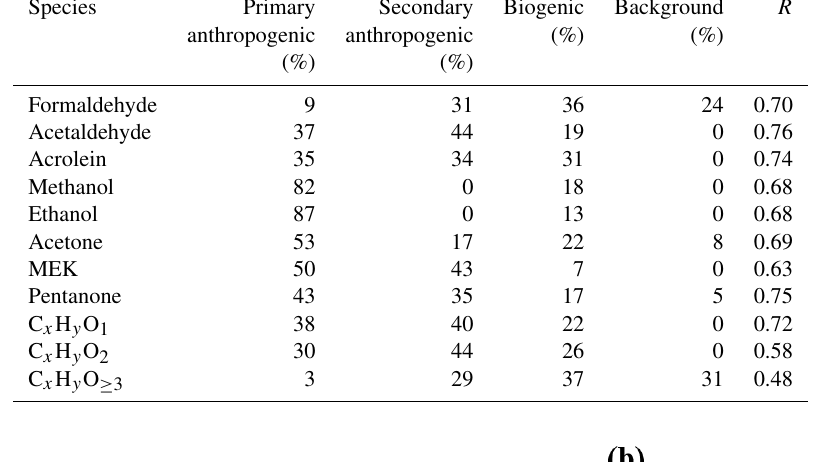
Table 3. Contribution fractions of OVOCs from different sources, and the correlation coefficient between calculated and measured OVOC concentrations.